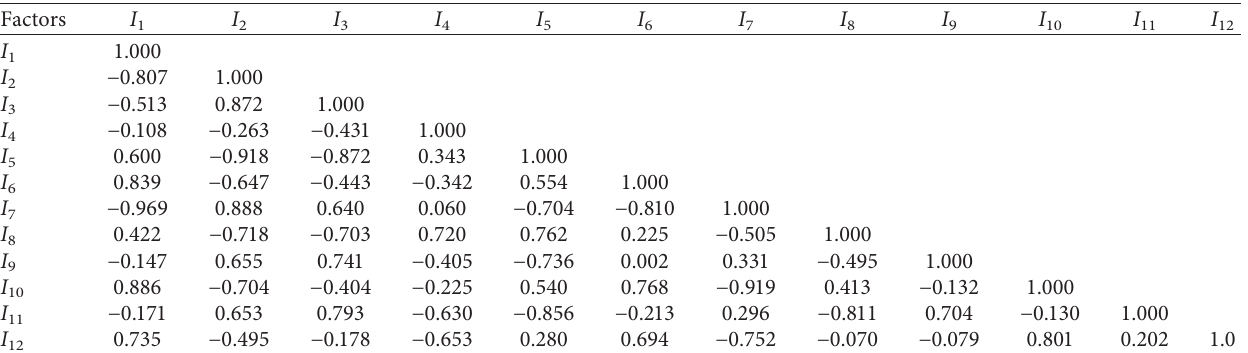
Table 3: Pearson correlation coefficient matrix of each factor.